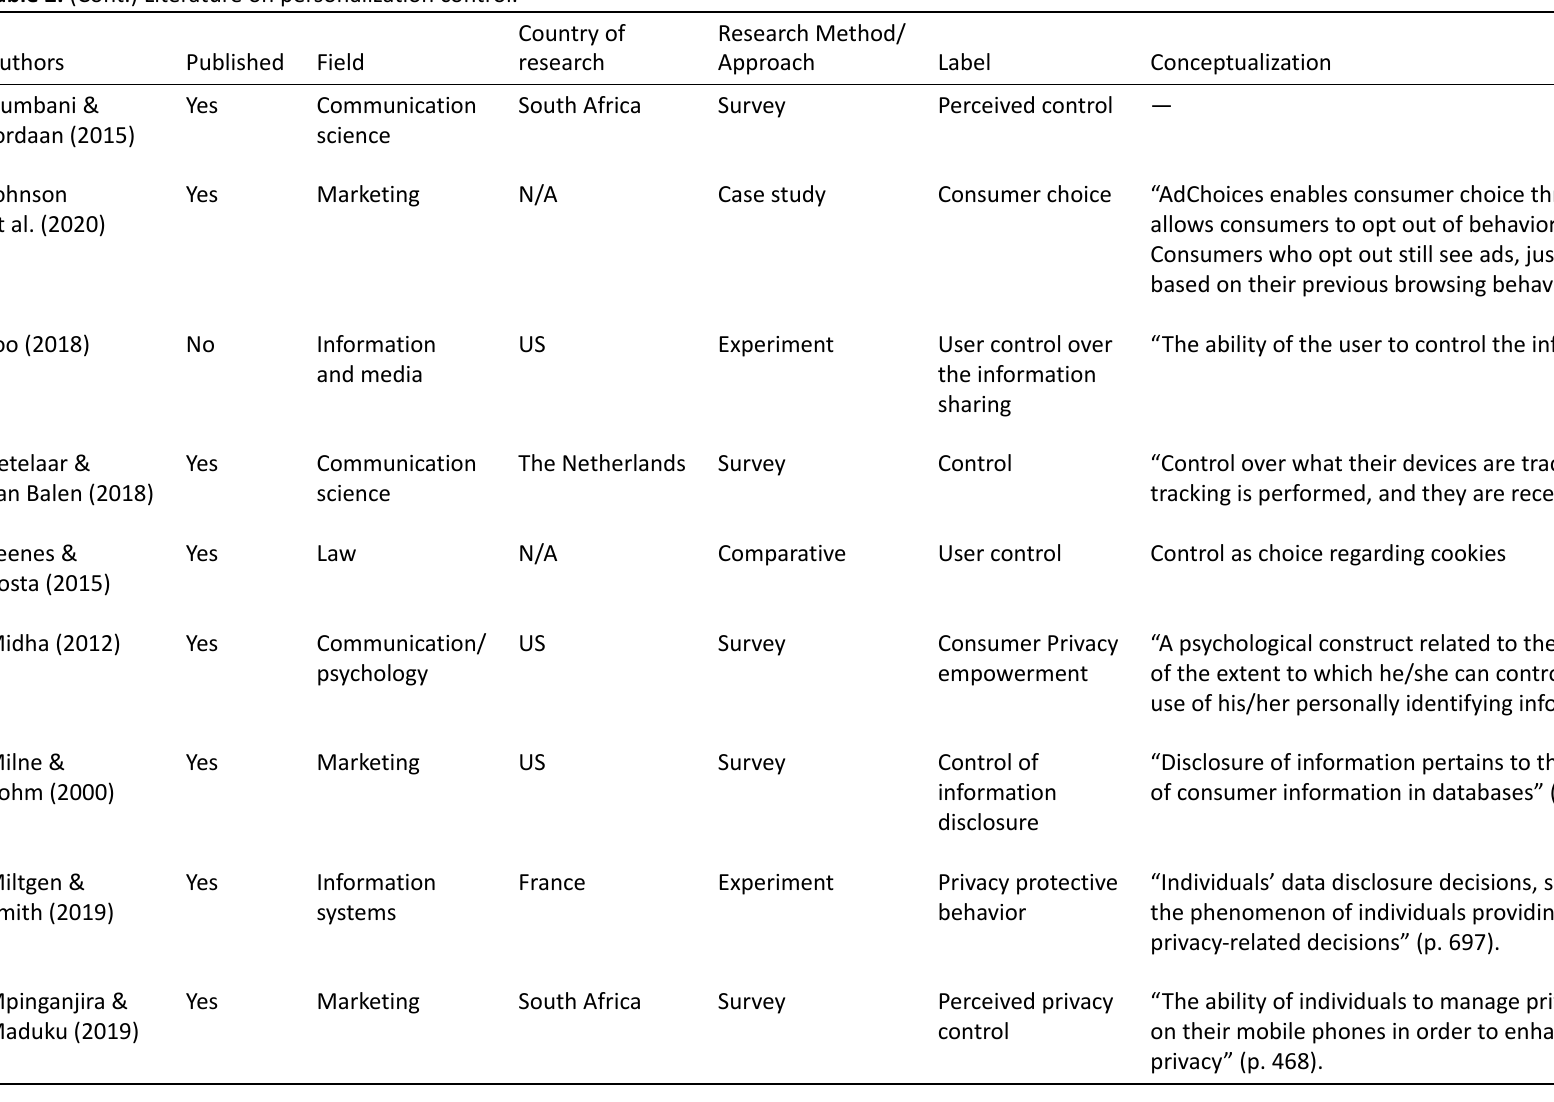
Table 2. (Cont.) Literature on personalization